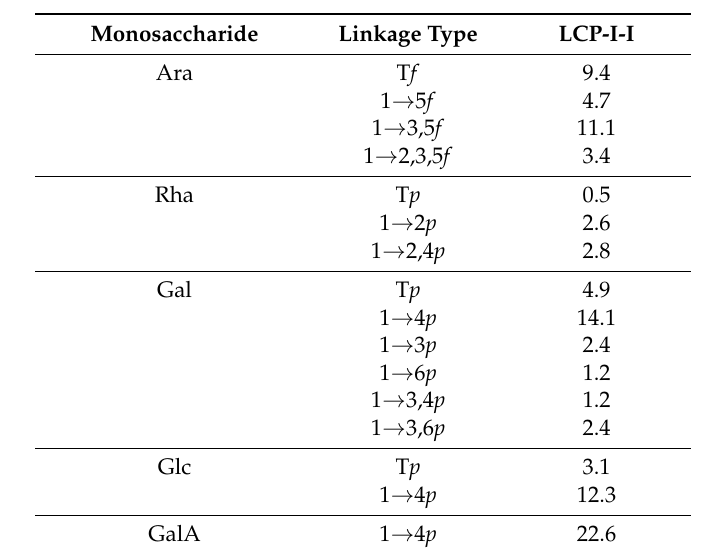
Table 2. The linkage composition (mol %) of the monosaccharides present in polysaccharide fractions LCP-I-I obtained from rhizomes of L. chuanxiong determined by Gas Chromatography-Mass Spectrometry (GC–MS) after